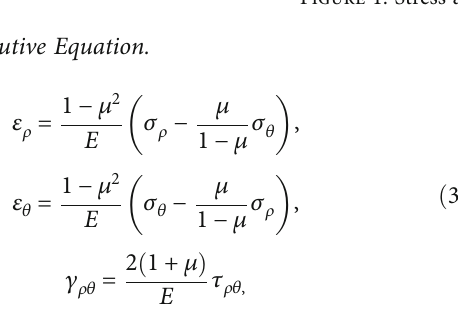
Figure 1: Stress analysis around